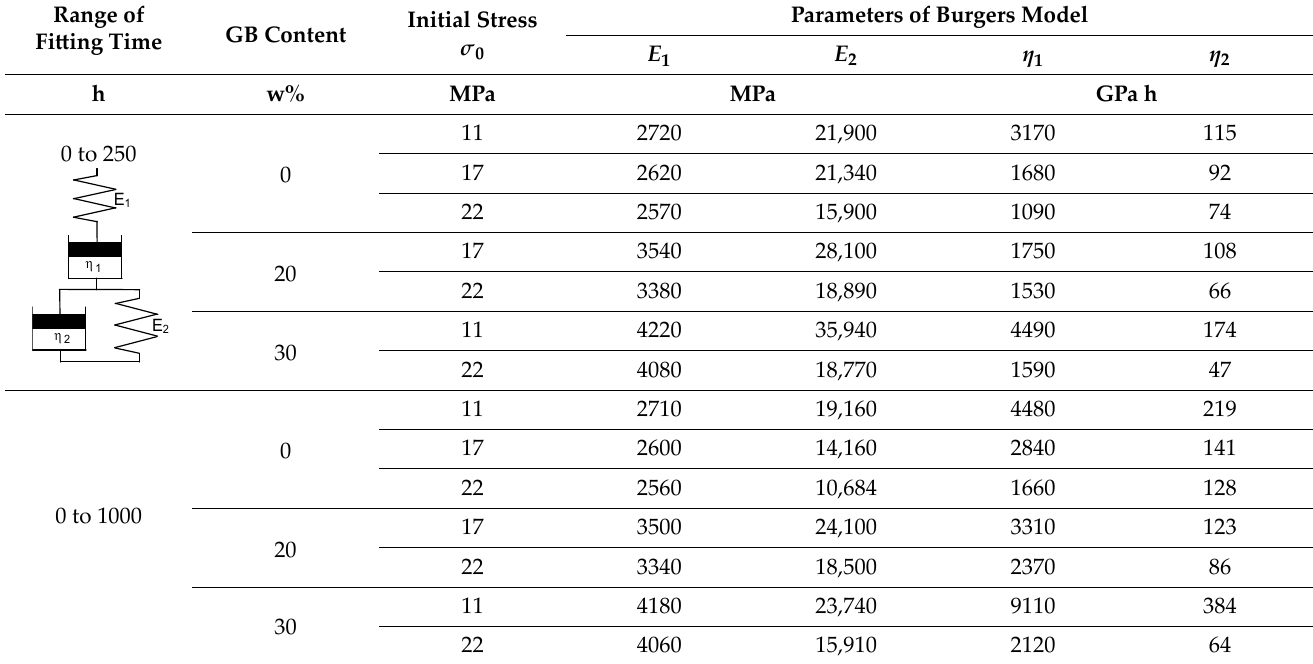
Table 2. Initial stress‑dependent parameters of Burgers model according to fitting creep compliance of neat PBT, PBT GB20, and PBT GB30 showing effect of chosen fitting time ranges.